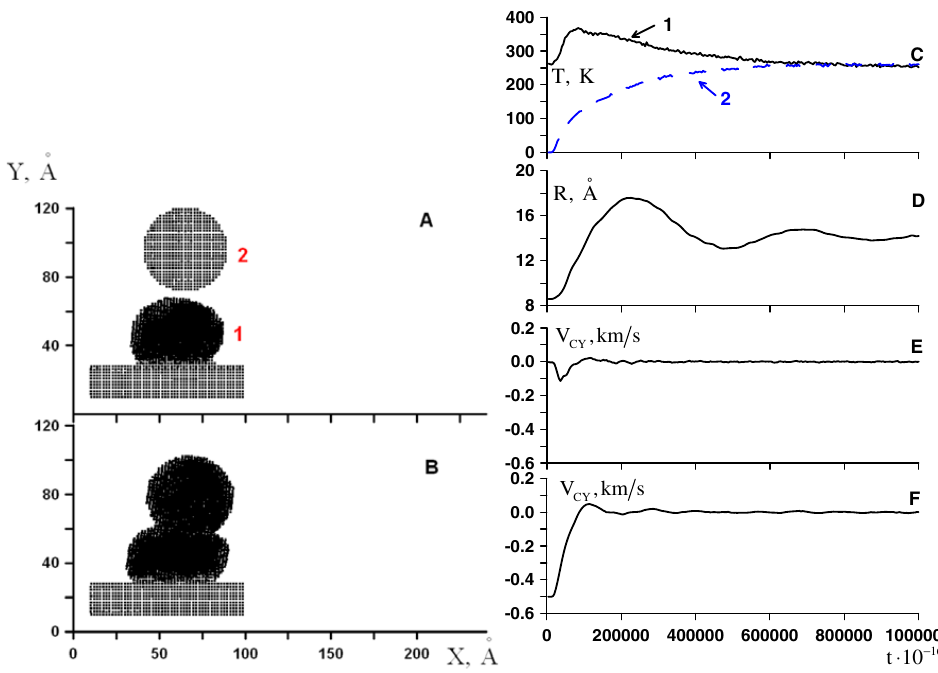
Fig. 2. Deposition of two nanoclusters. Initial (A) and final (B) positions (100 ps) of the clusters in the XY plane. Dependences of the kinetic temperature for both clusters (C), the distance between center of the mass of the clusters (D), Y-components of the mass velocity (E - first cluster, F - second cluster) versus time. Clusters diameter is 50Å. Initial velocity is 500 m /